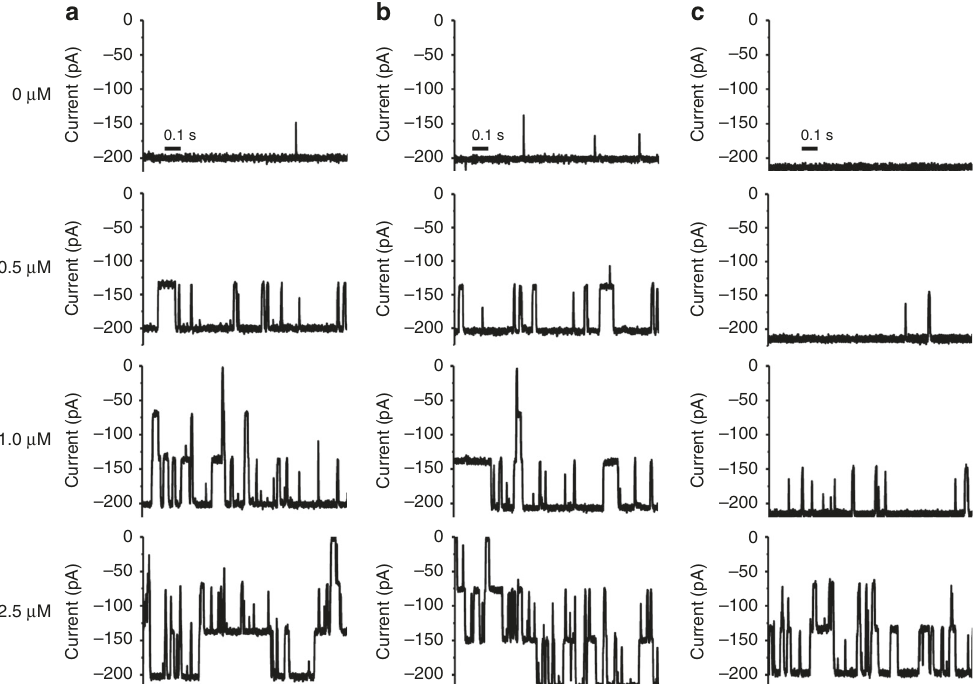
Fig. 9 Chitoxexaose binds to Vh ChiP with high af fi nity. Single-channel electrophysiology experiments for natively expressed Vh ChiP ( a ), refolded Vh ChiP ( b ), and N-terminally truncated Vh ChiP ( c ). The fully open Vh ChiP trimeric channels were exposed to different concentrations of chitohexaose. Ion current traces were acquired at − 100 mV with sugar added on the cis side. For full trace recordings of 2 min duration and analyses see Supplementary Figs. 3 –